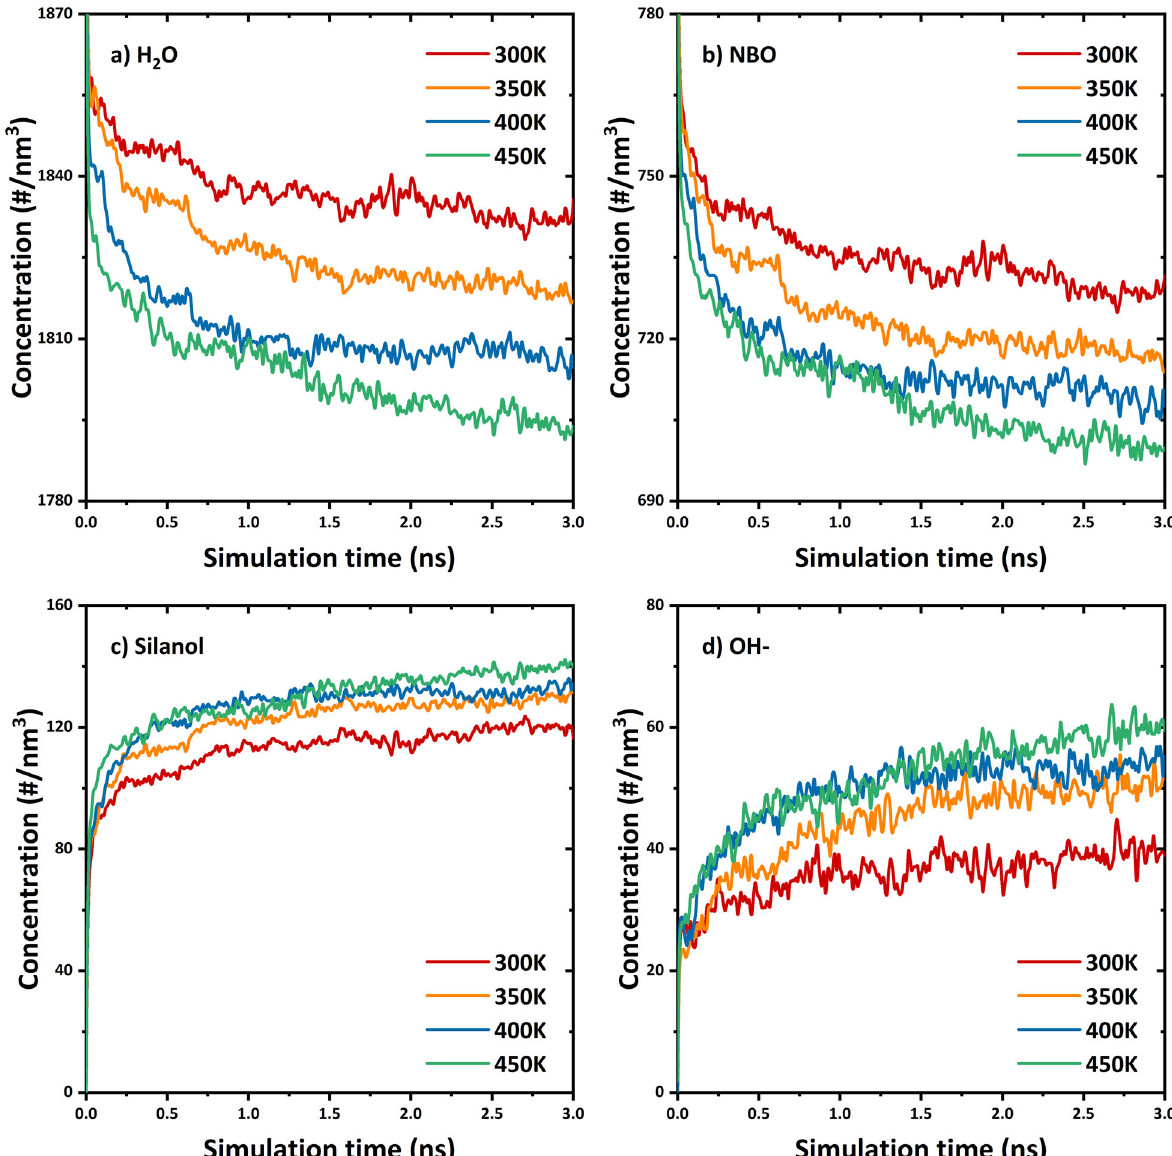
Fig. 10 Evolution of the reactants and products concentrations (Eq. 1) up to 3 nano-seconds. a H 2 O, b NBO − , c silanol group, and d OH − group,